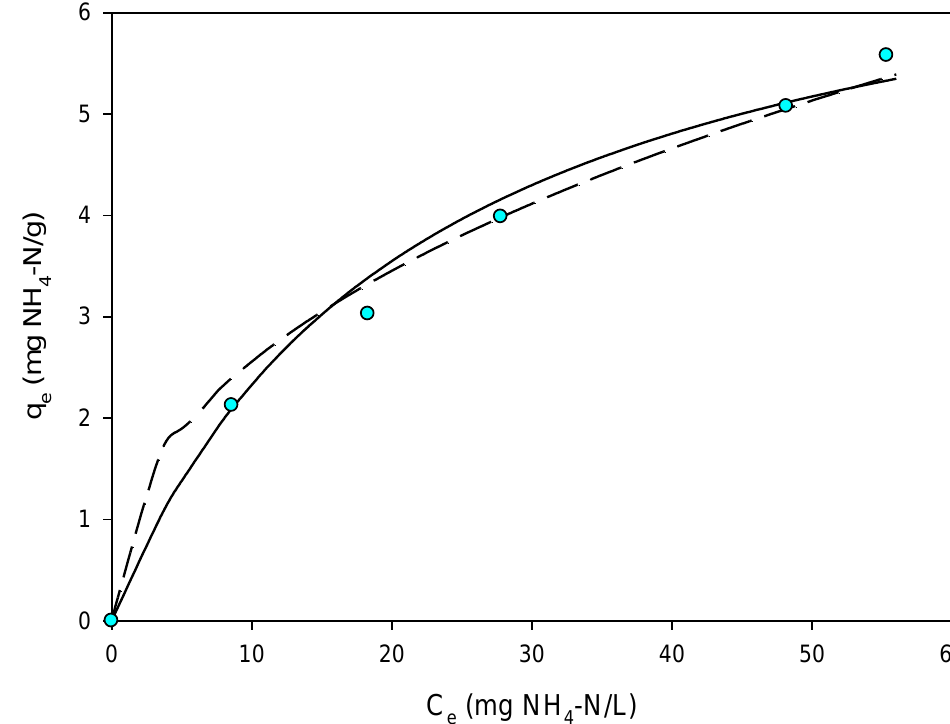
Figure 8. Experimental and theoretical equilibrium isotherms for ammonium removal by Na-Z with AnMBR permeate. Langmuir (continuous line) and Freundlich (dashed line) models.